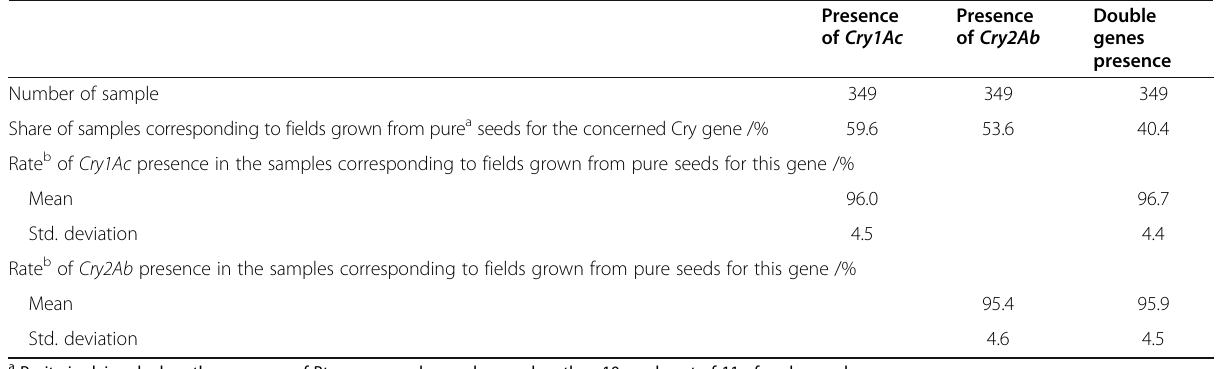
Table 4 Purity status of Bt seeds in samples from Bt-cotton fields